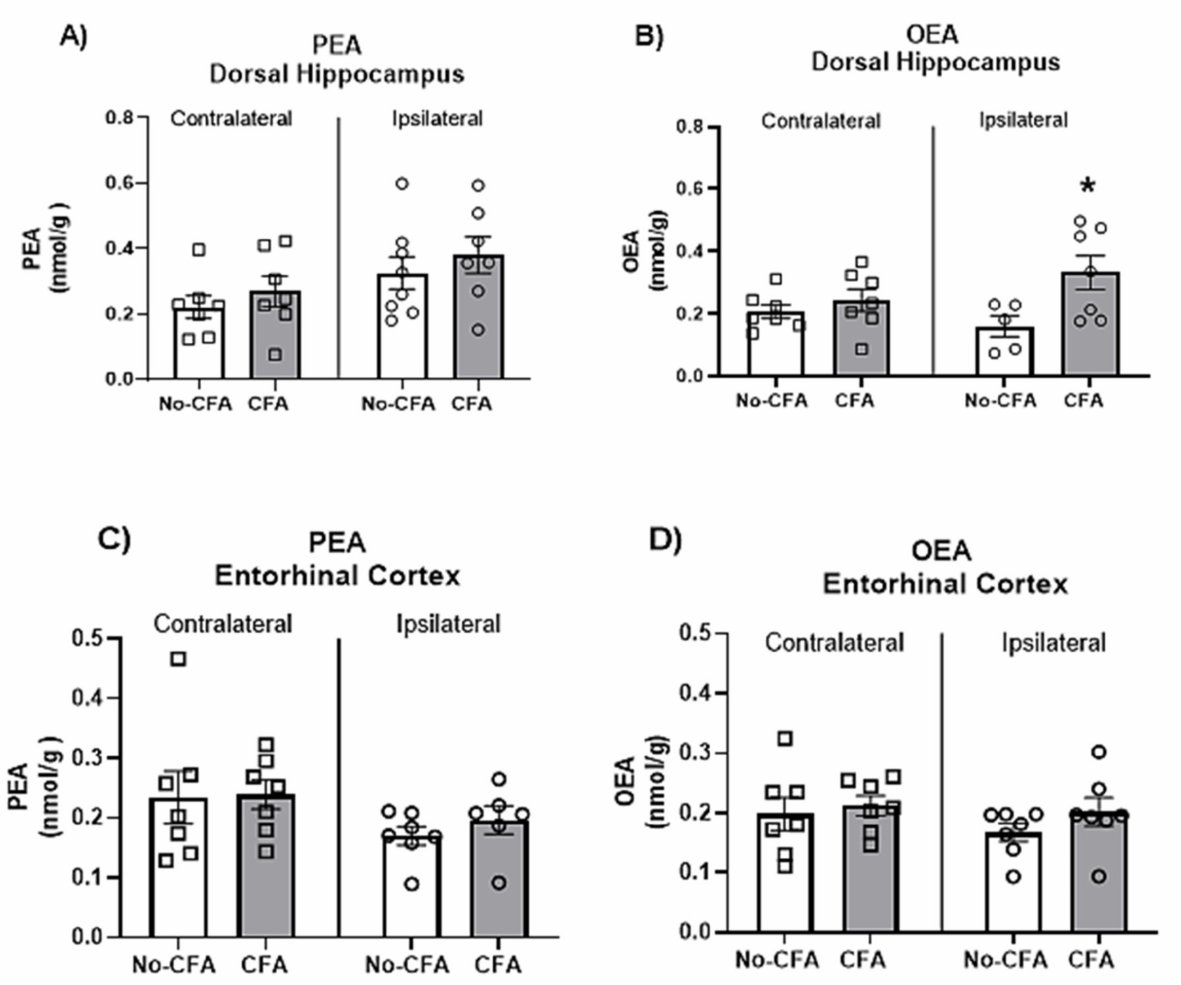
Figure 8. Effects of intraplantar injections of CFA in vehicle-treated animals on the levels of OEA and PEA in the dorsal hippocampus ( A , B ) and entorhinal cortex ( C , D ). Two-way ANOVA has shown a significant overall effect of CFA on the levels of OEA in the dorsal hippocampus ( B ). Post hoc analysis with Student Newman-Keuls test indicated that OEA levels were significantly higher in the ipsilateral dorsal hippocampus of the CFA-vehicle group compared to No-CFA counterparts ( B ; * p < 0.05, vs. no-CFA; d = − 0.390). Data are expressed as means ± SEM ( n = 7–8 rats per